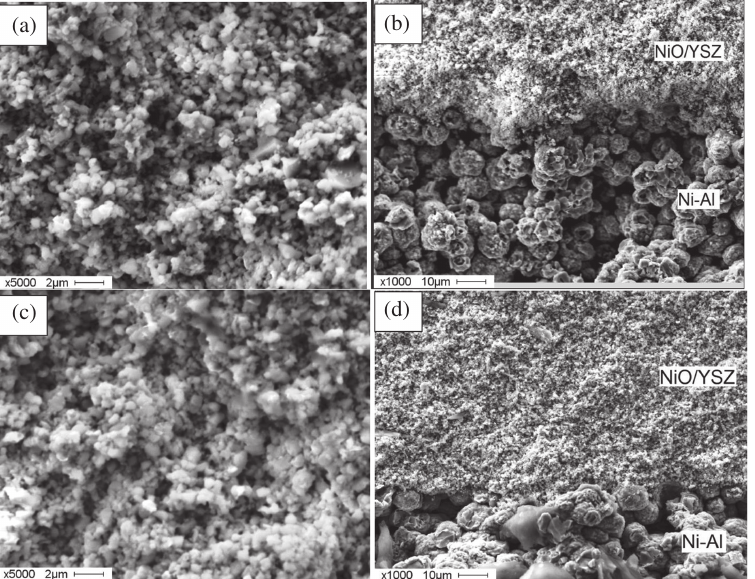
Figure 6: The surface (a, c) and cross-section (b, d) of NiO-YSZ layers after sintering by SPS in Ar at 1,100°C for 5 min (a, b) and for 10 min (c, d). Pressure is 15 MPa.